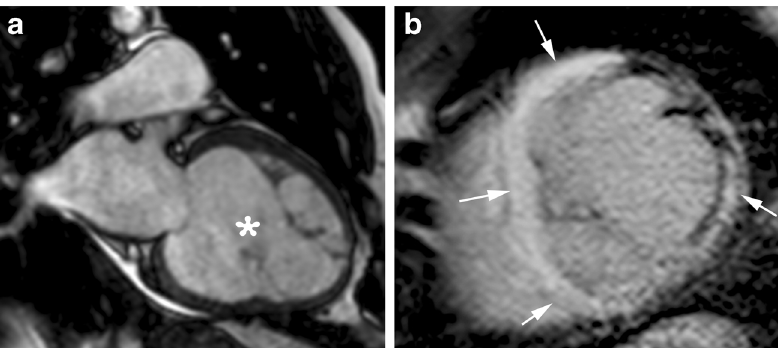
Fig. 12 End-stage HCM with dilated form. 69-year-old man with long- standing asymmetric septal HCM who presented with dyspnea at rest and congestive heart failure. a , Two-chamber SSFP cine MR image shows regression of wall thickness, increase in left ventricular cavity dimensions